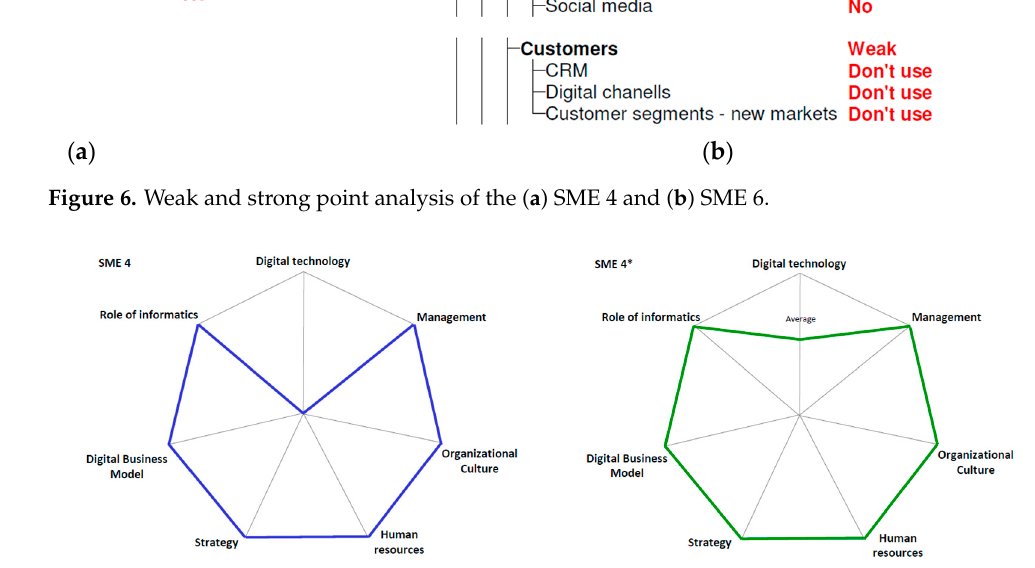
Figure 7. Polar chart for “ what-if ” analysis of SME 4 and SME 4*.